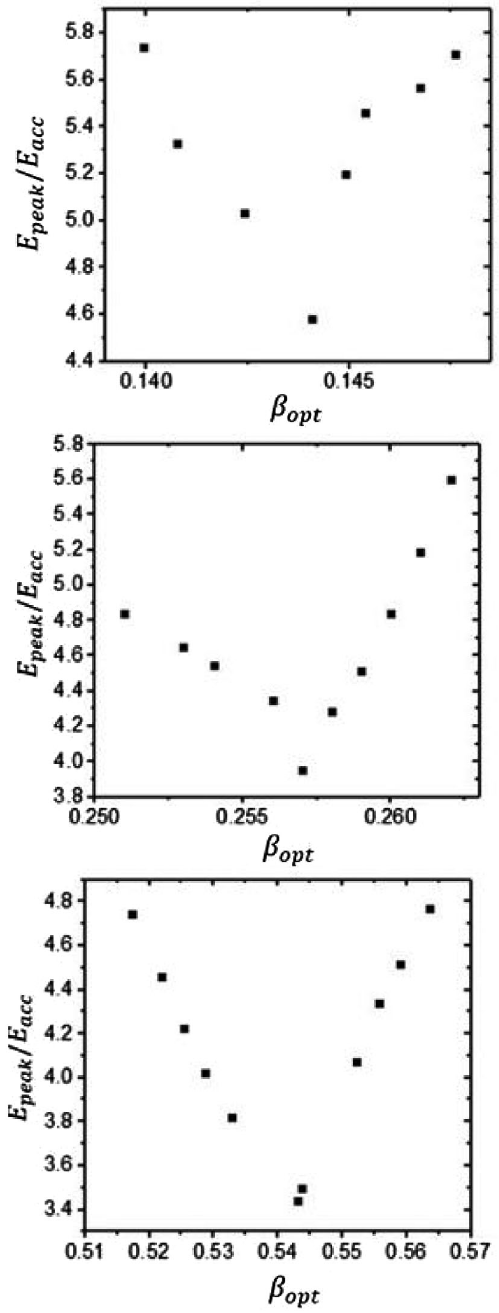
FIG. 20. Variation of peak field ratio with the change in the optimal beta of the